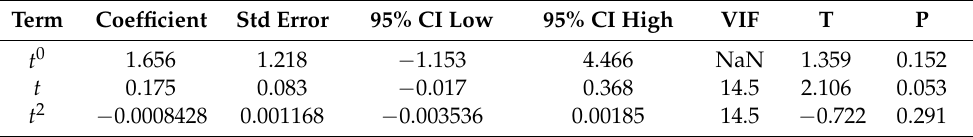
Table 3. Results of statistical analysis, for the interpolation (using second-degree polynomial) of lettuce diameter crowns variation over time, grown in soil with 4.5% zinc